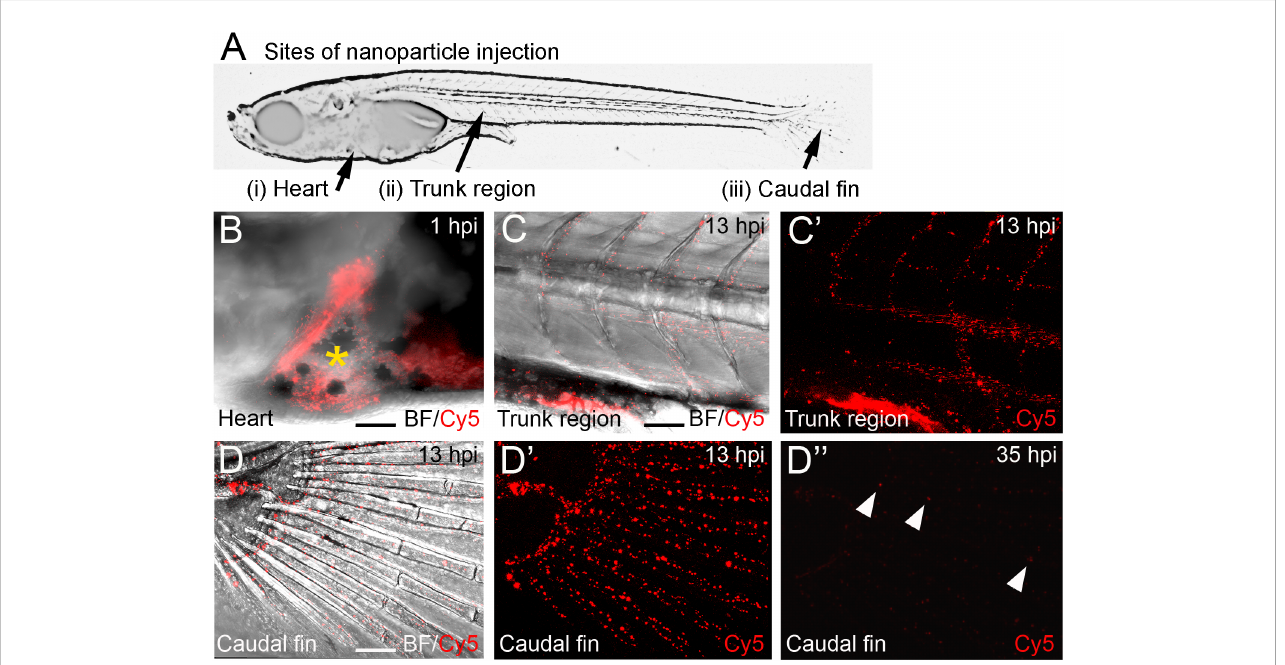
FIGURE 2 Distribution of Cy5-labelled calcium phosphate nanoparticles after injection into medaka larvae. (A) Schematic image of a medaka embryo at 11 days post fertilization (dpf) indicating sites of nanoparticle injection, i.e. heart, muscle fi ber region in the rostral trunk and between bony rays of the caudal fi n. (B) Merged image of bright fi eld (BF) and Cy5 channel of larval medaka heart at 1 hour post injection (hpi). Cy5 (red) indicates nanoparticles around injection site marked by yellow asterisk. (C, C ’ ) After heart injection, Cy-5-labeleld nanoparticles are detectable in blood vessels of the trunk at 13 hpi. A merge of bright fi eld and fl uorescence image (C) and the fl uorescence image alone are shown (C ’ ) . (D, D ” ) After heart injection, Cy5-labelled nanoparticles are detectable in blood vessels of the caudal fi n at 13 hpi (D- D ’ ) and show strongly reduced fl uorescence at 35 hpi (D ” ) . Arrowheads mark remaining fl uorescently labeled particles. Ten embryos were analysed and showed this phenotype. Scale bars = 90 m